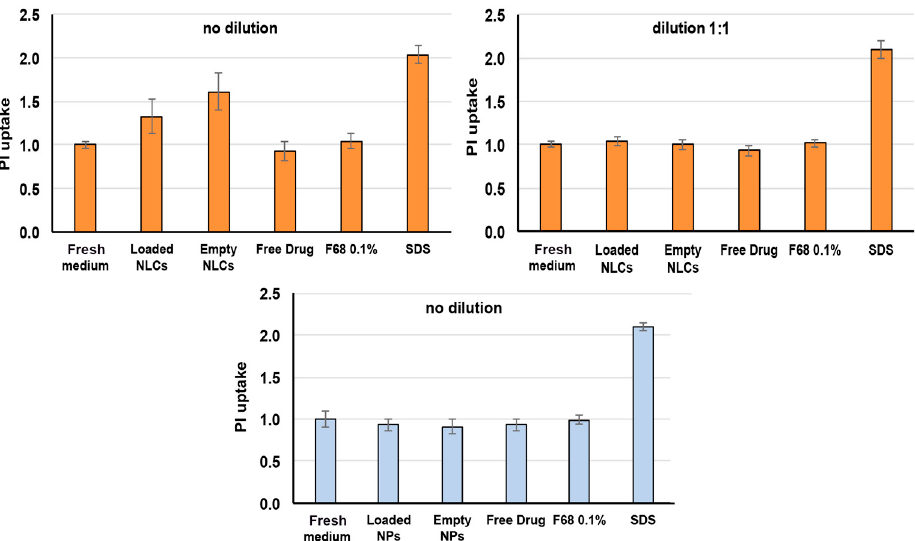
Figure 4. Propidium iodide (PI) uptake by Caco-2 cell line after 24 h incubation with empty and CEF-loaded NLCs (orange bars) or CS NPs (blue bars) and their components. Fresh culture medium and SDS (1 mg/mL) were used as negative and positive control. Results are expressed as relative fluorescence intensity (RFI) with respect to cells incubated with culture medium (mean ± SD, 4 replicates per plate in 3 independent plates).